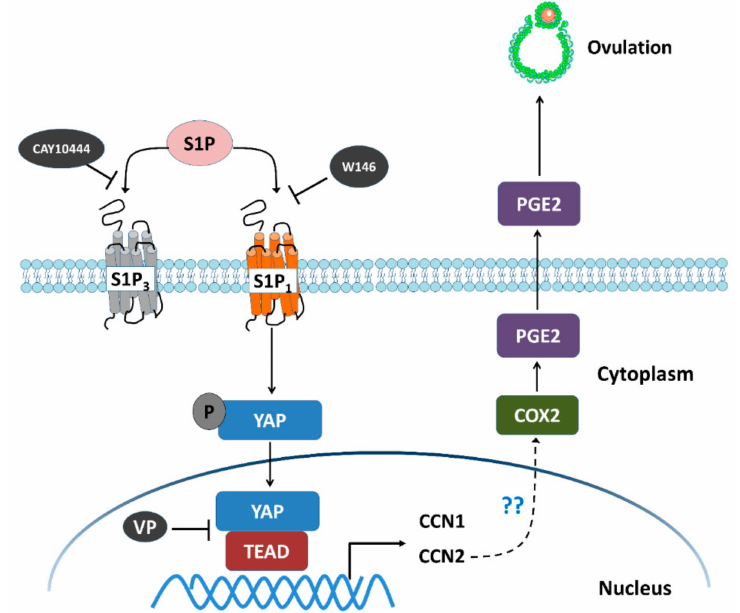
Figure 8. Schematic diagram representing the molecular mechanism underlying the S1P-induced upregulation of COX2 expression and the increase in PGE2 production in human granulosa-lutein cells. S1P binds to S1P receptors S1P 1 or S1P 3 in human granulosa cells. Combination of S1P and S1P 1 induces nuclear translocation of YAP, which, in turn, upregulates the expression of CCN1 and CCN2. The increased level of CCN2, but not CCN1, upregulates the expression of COX2 and increases the production of PGE2, which eventually induces ovulation. W146 (an antagonist of S1P 1 ) or verteporfin (VP, an antagonist of YAP), but not CAY10444 (an antagonist of S1P 3 ), significantly inhibit the S1P-induced upregulation of COX2 expression and the increase in PGE2